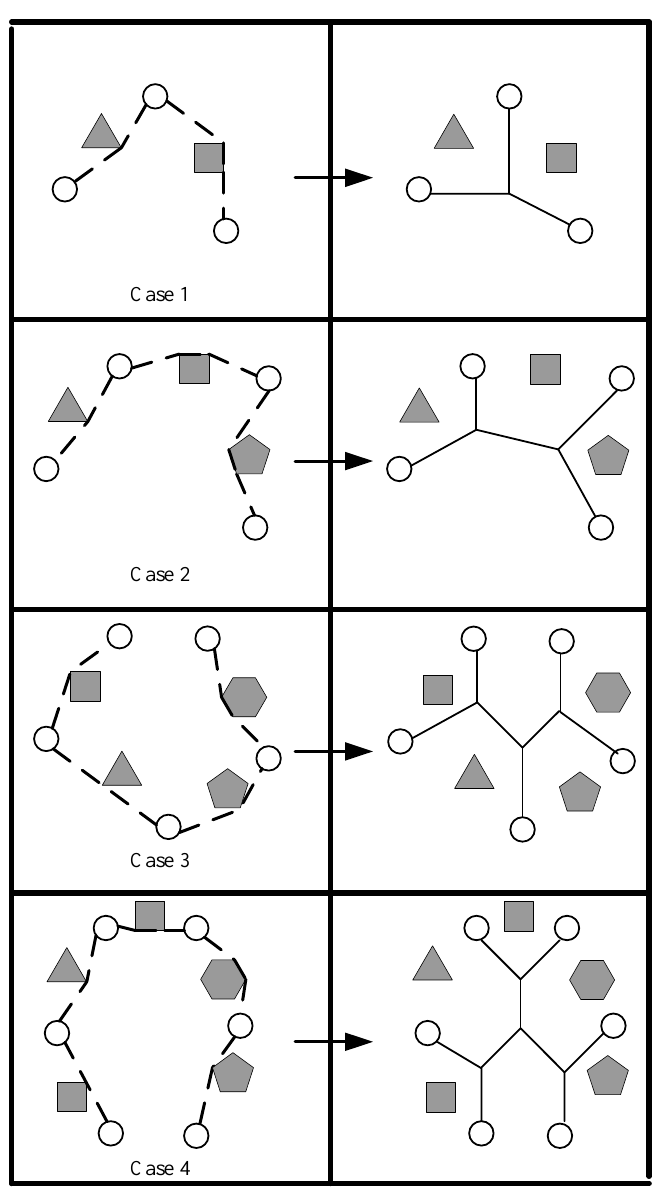
Figure 2. The obstacle avoidance by straight